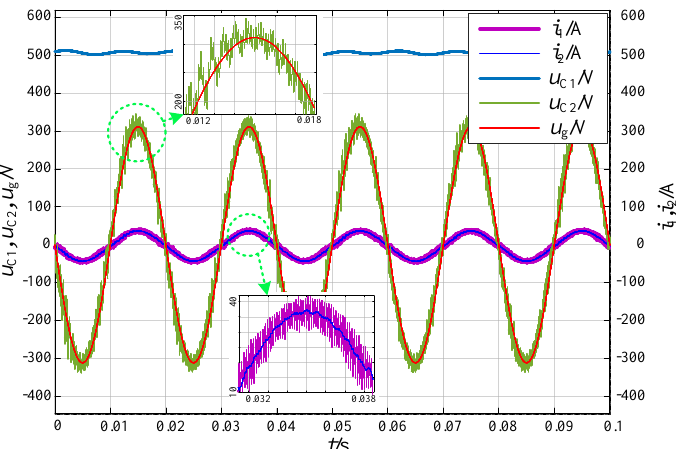
Figure 5. Time-domain waveform of system variables under predictive control.